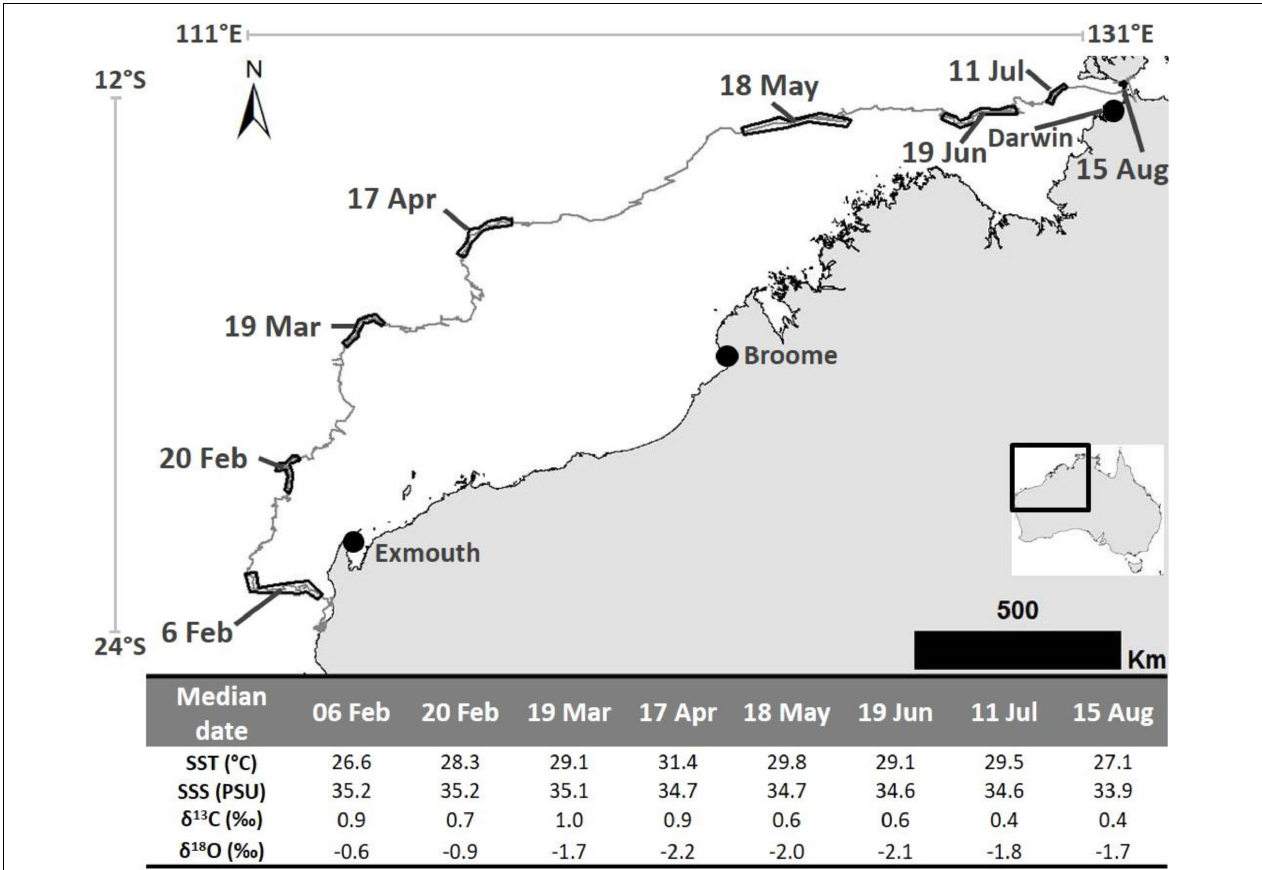
FIGURE 2 | The 2016 post-nesting migration pathway of a loggerhead turtle that was tagged on the Western Australian coast and traveled to near Darwin. Dated black outlines on telemetry track represent the location at which each barnacle shell sample was expected to have been created. Table at base shows calculated (median date and mean SST and SSS) and analyzed parameters ( δ 13 C and δ 18 O values) for each sample. Satellite telemetry data were obtained from the Gnaraloo Turtle Conservation Program for the Gnaraloo Wilderness Foundation.